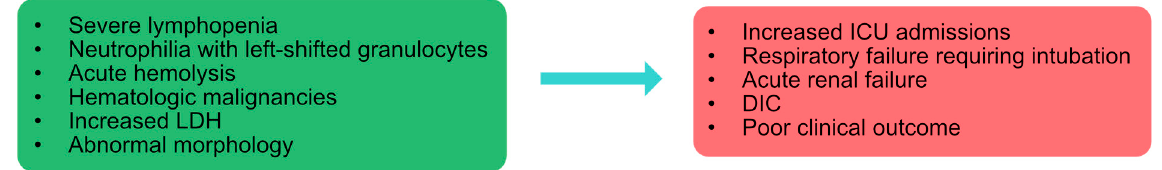
Figure 3. Summary of hematologic complications observed in patients hospitalized with COVID-19